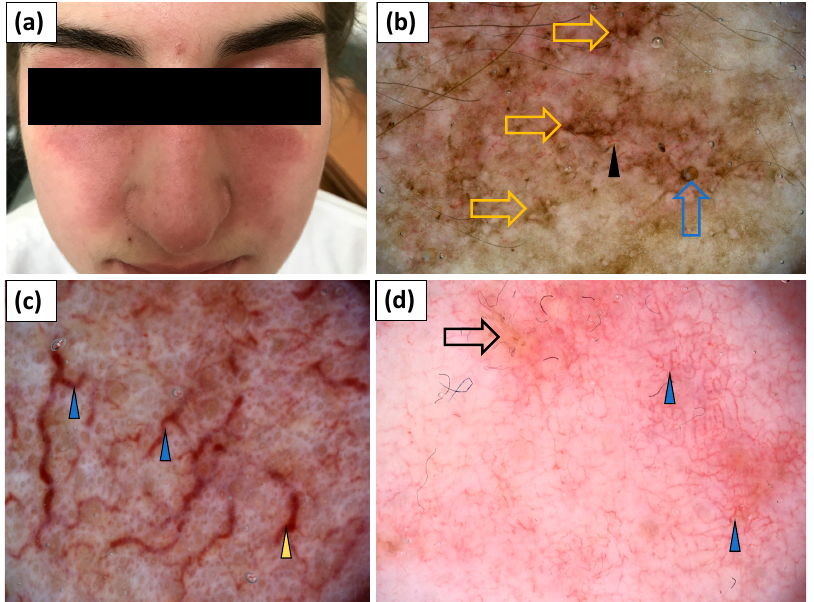
Figure 7. ( a ) Clinical presentation of erythematous lesions on the face. ( b – d ) Videodermoscopy of lesions on the face showed irregularly distributed linear vessels (black arrowhead), linear vessels with branches (blue arrowhead) and linear curved vessels (yellow arrowhead), yellow structureless areas (black arrow), follicular plugs (blue arrow), and stellate brown structures (yellow arrow).